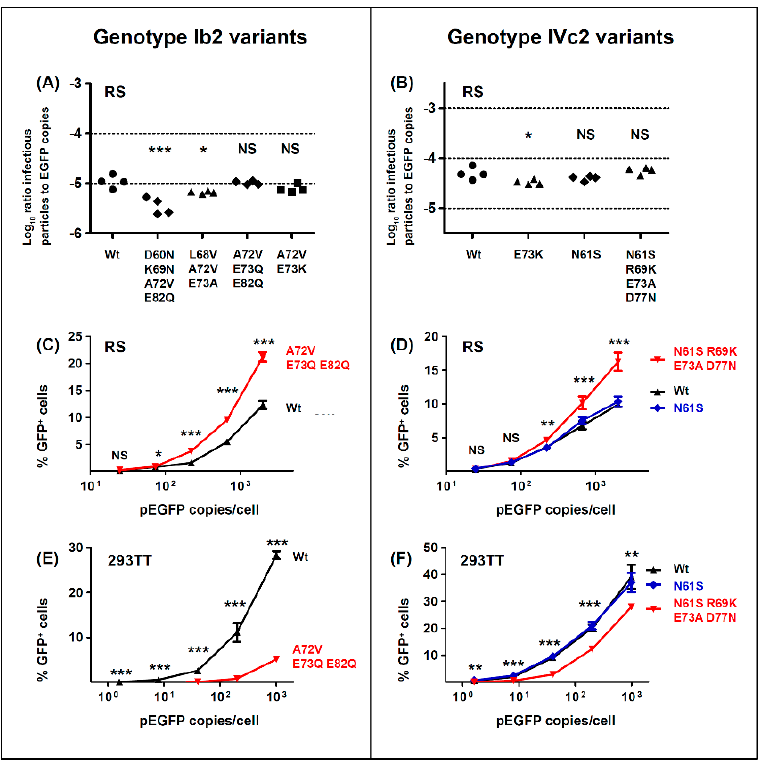
Figure 5. Opposite effects of BC-loop mutations on pseudo-type infectivity in RS and 293TT cells. Infectivity in RS cells of PSV with genotype Ib2 ( A ) and genotype IVc2 ( B ) VP1 variants. Percentage of infected RS cells as a function of input PSV dose for wild type gIb2 PSV compared to the V 72 Q 73 Q 82 mutant ( C ) and wild type gIVc2 PSV compared to the S 61 and S 61 K 69 A 73 N 77 mutants ( D ). Percentage of infected GFP + 293TT cells for the same gIb2 ( E ) and gIVc2 PSV ( F ). In the experiments shown, the gIb2 Wt and V 72 Q 73 Q 82 PSV were produced in parallel in the same production lot, as were the gIVc2 Wt S 61 and S 61 K 69 A 73 N 77 PSV. The percentage of GFP + cells at each PSV dose was compared by two-tailed t-test ( C , E ) or by ANOVA followed by Dunnett’s post-hoc test ( D , F ). *** p < 0.001; ** p < 0.01, * p < 0.05. The results of one representative experiment of at least two independent experiments are shown. Error bars indicate the StDev of quadruplicates.